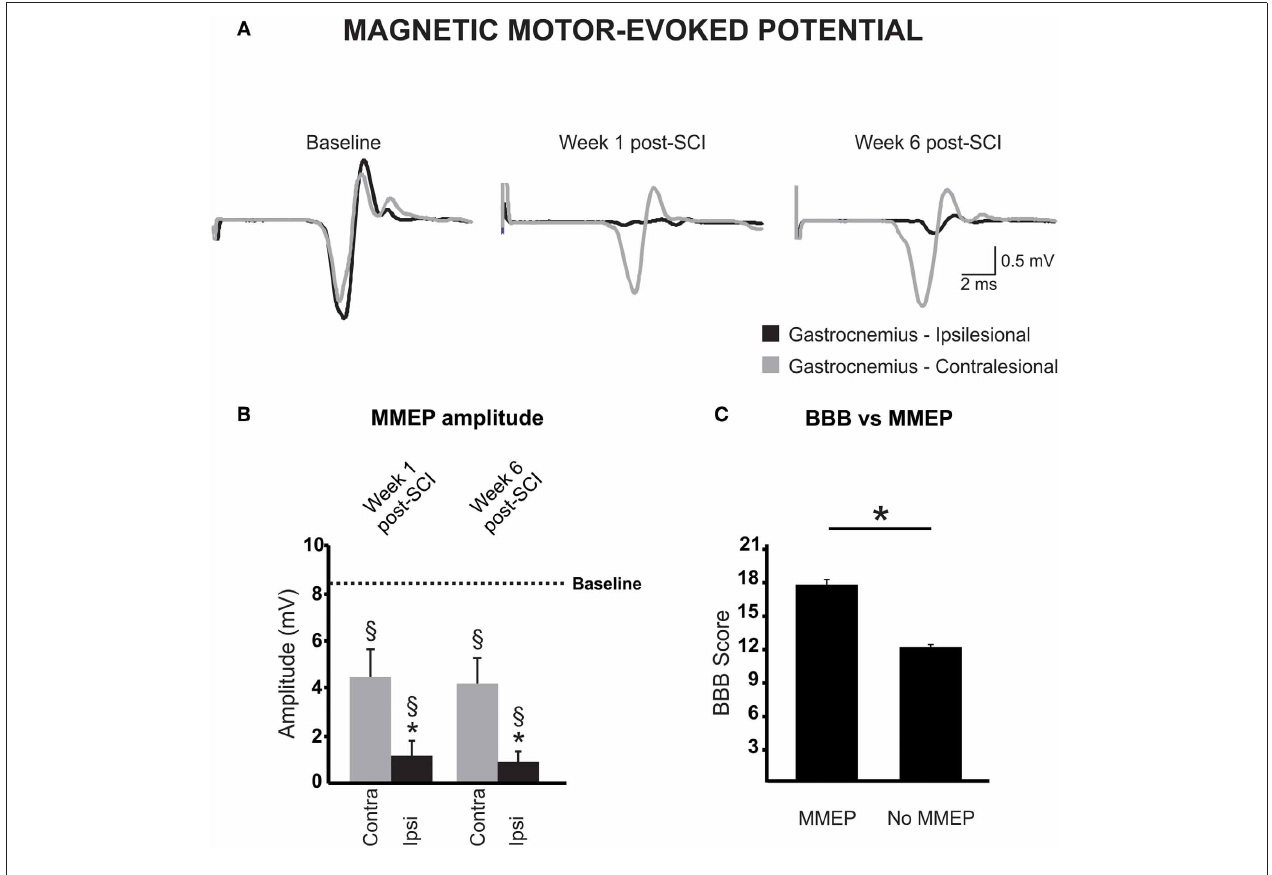
FIGURE 4 | Magnetic motor-evoked potential (MMEP) partly recovers after a cervical hemicontusion injury. (A) MMEPs recorded from the contralesional (gray) and ipsilesional (black) gastrocnemius (GS) muscles disappear on the ipsilesional side after SCI and partly recovers over time.